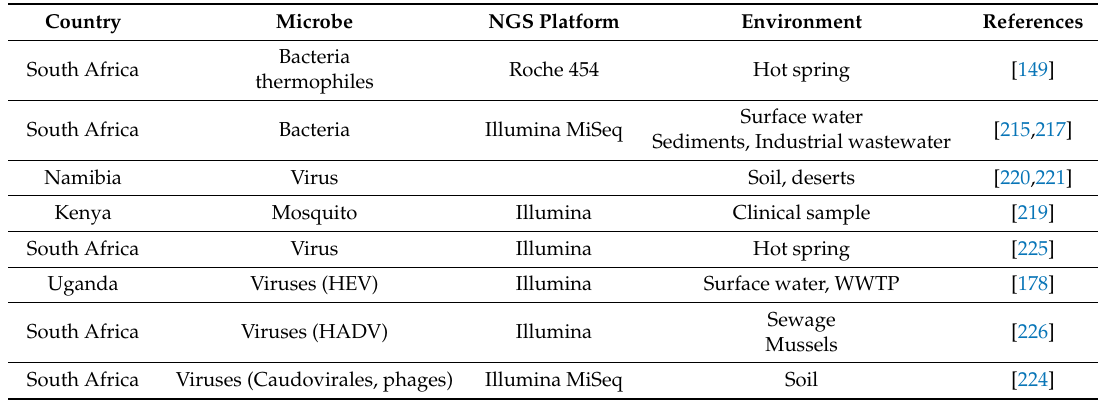
Table 6. Recent studies and application of metagenomics in some African